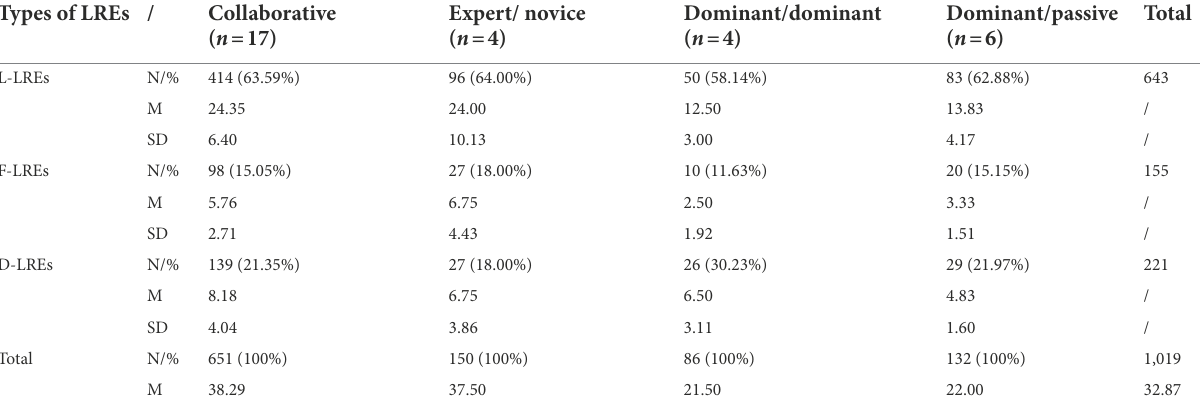
TABLE 1 The frequency and type of Language-Related Episodes (LREs) by dyadic patterns. Types of LREs /